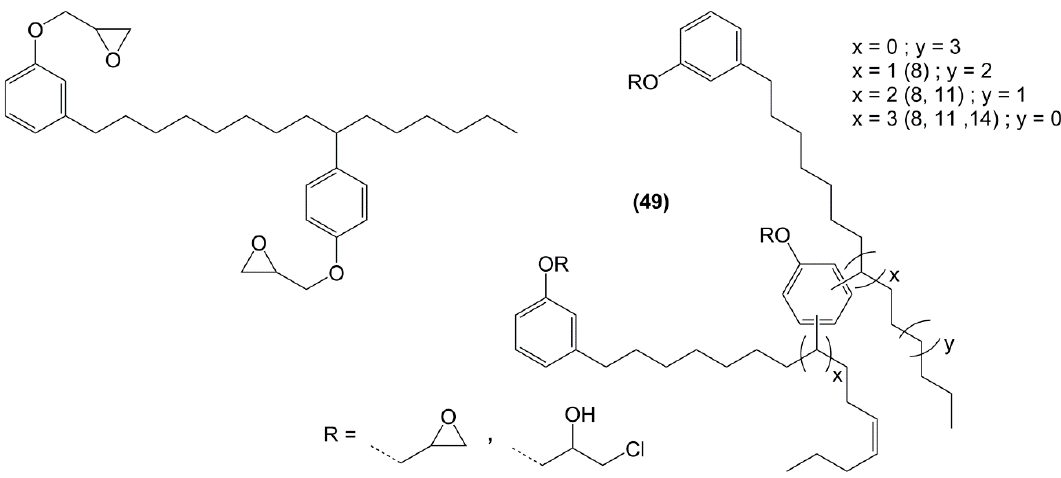
Figure 29. Idealized structure of phenolated cardanol (left) and real structure ( 49 ) of NC514 by Cardolite. The numbers between brackets indicate the locations of the phenol moieties along the aliphatic alkyl chain.